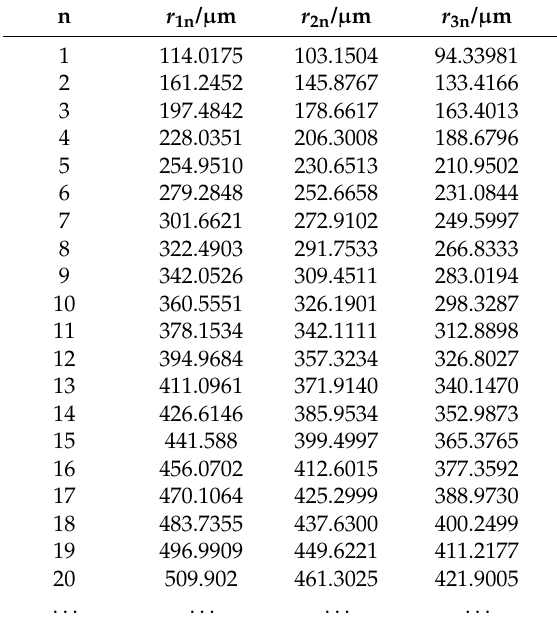
Table 1. Radius values of multi-spectral structure in different annular